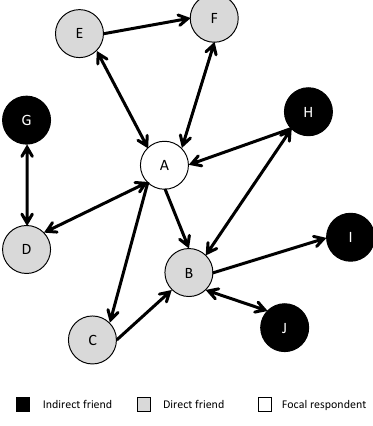
Figure 1: Illustration of direct and indirect friends in a network